Question: Generate an informative caption for the figure above.
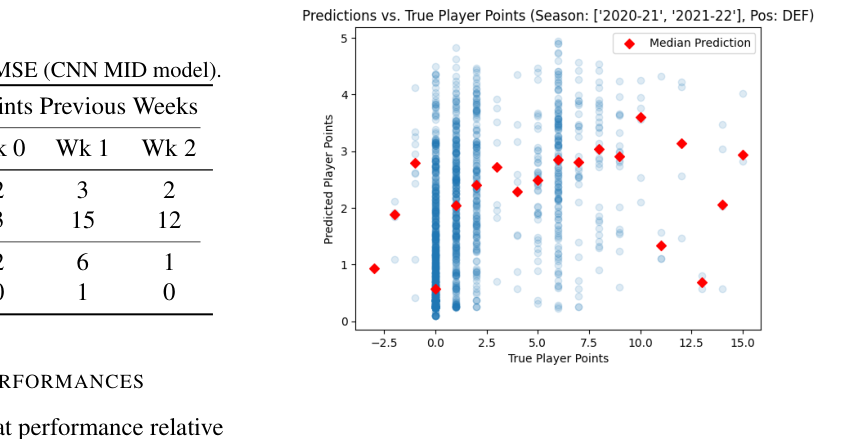
Answer: Midfielder Predictions vs. True Performance (Holdout Data)